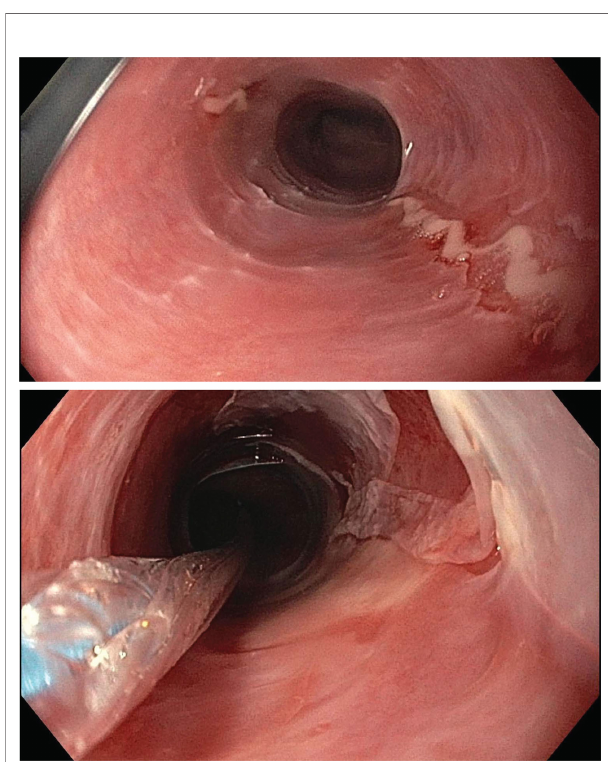
FIGURE 1 | Endoscopic assessment of esophagitis in proband. Upper endoscopic assessment of the esophagus in our proband given history of recurrent esophageal strictures. Top: a ringed esophagus with linear ulcerations. Bottom: post balloon dilation, demonstrating sloughed, paper-thin esophageal mucosa without any evidence of deeper